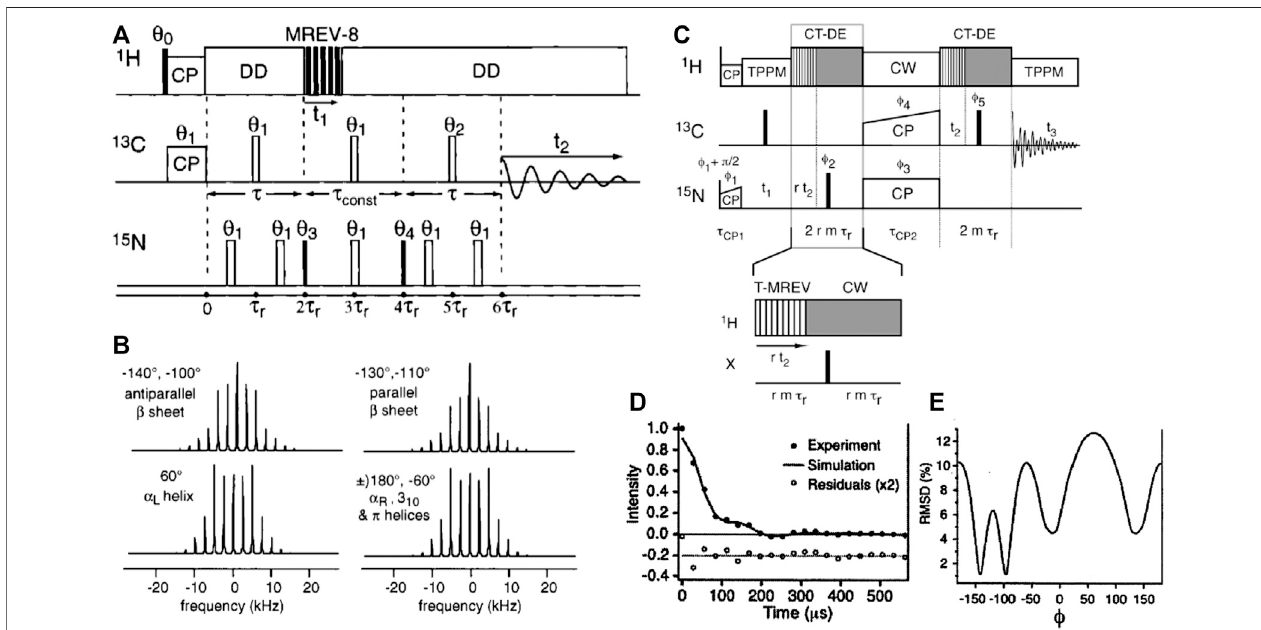
FIGURE 7 | HCNH measurement of the ϕ backbone angle. (A) Pulse sequence for the HCNH experiment, where MREV-8 is used to achieve 1 H- 13 C/ 15 N dipolar recouplingof 13 C- 15 Ncorrelations. (B) Exampledipolarlineshapesforfourdifferent ϕ angles,basedonsimulations.Notethatonelineshapeoftenrepresentstwodistinct ϕ angles,asindicated.The fi gurealsoliststhematchingsecondarystructures,showingthateachtypeofsecondarystructurehasacharacteristicspectrallineshape. (C) PulsesequenceofaHCNHexperimentbasedonatransfer-likeimplementationsimilar tothoseshown in Figure6 . (D,E) Representative results showinghowalso thisvariantpointstomultipleminima.Adaptedwithpermissionfrom (A,B) ref.(Hongetal.,1997a)and (C – E) (Rienstraetal.,2002a),Copyright1997and2002American Chemical